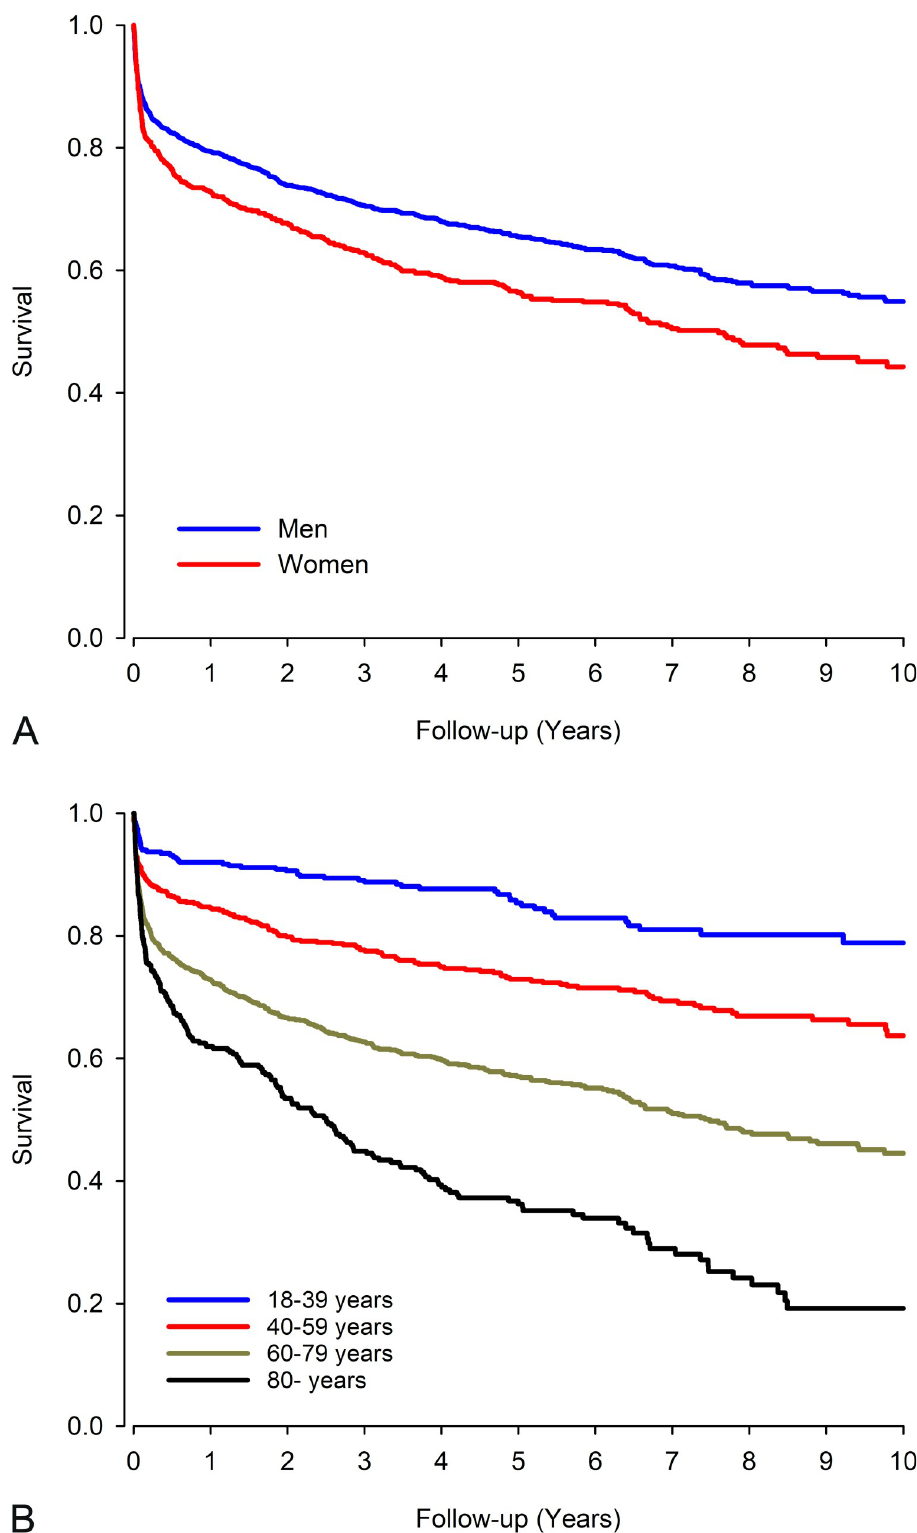
Fig 2. Ten-year survival of patients with infective endocarditis admission during 2005–2014 in Finland by A) sex B) age group.